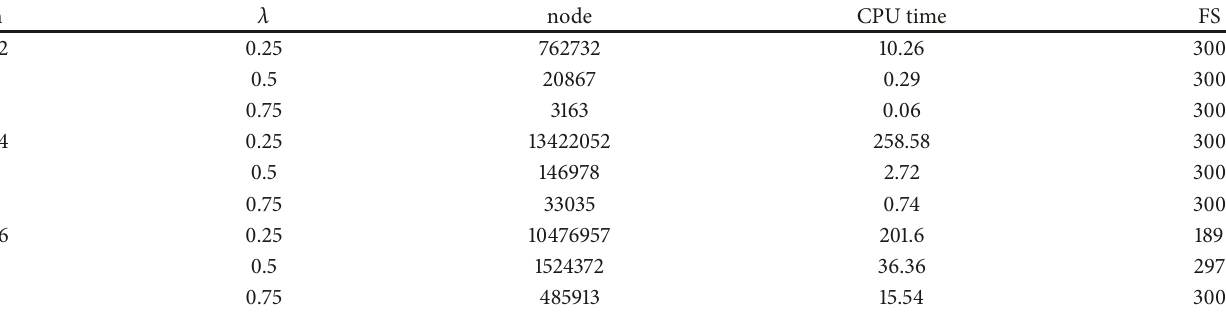
Table 3: The impact of 𝜆 in the branch-and-bound